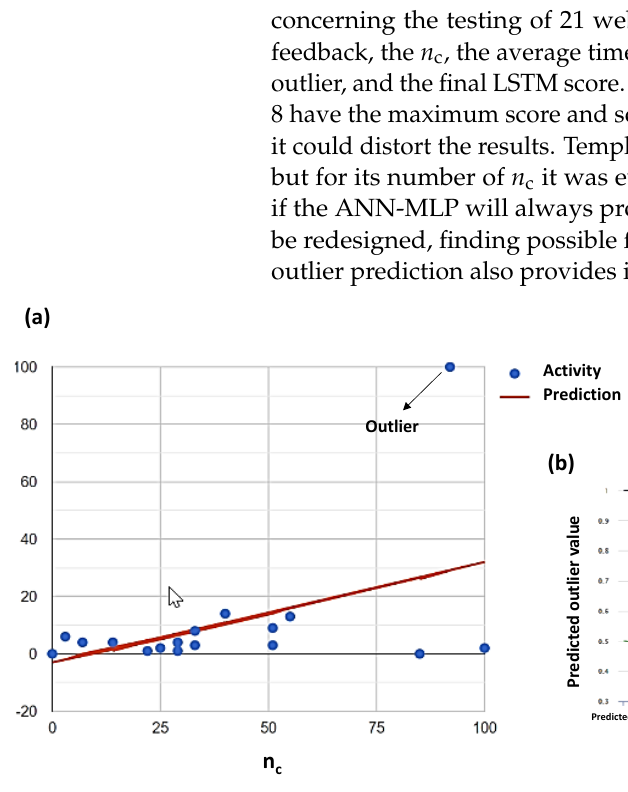
Figure 10. UX and outlier dashboard: ( a ) mouse movements versus the number of clicks n c . , ( b ) Example of ANN-MLP outlier prediction: the dates refer to the next four predicted days (Predicted Day 1 is the day after the calculus day). Table 4. Data of tests performed about